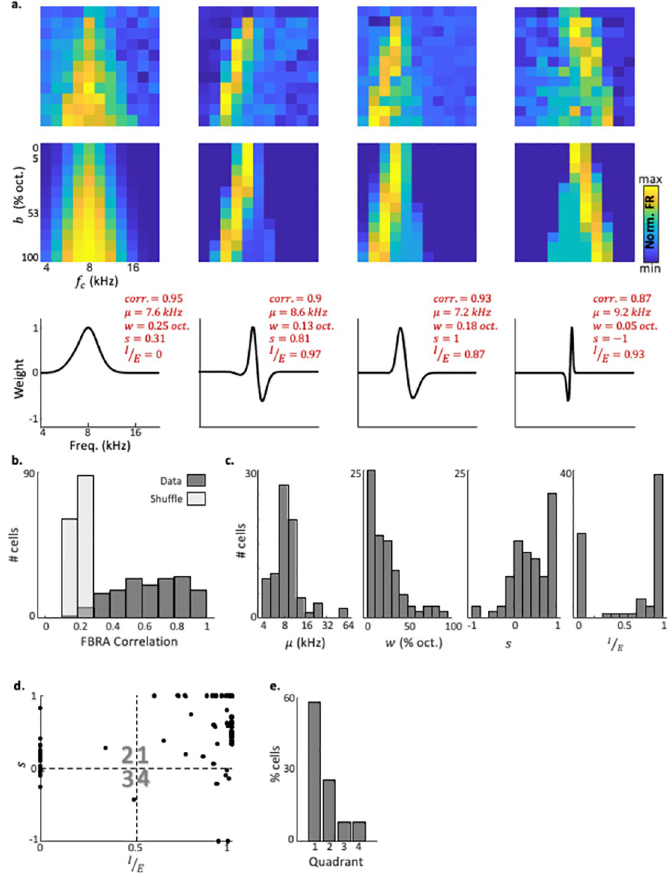
Fig 3. The MRW model provides a mechanistic explanation to neuronal FBRAs. a. Top: FBRAs of 4 neurons from 3 mice. Middle: model FBRAs fitted to the same neurons. Bottom: fitted MRWs of the same neurons. b. Distribution of FBRA correlation values (Pearson correlation) for all neurons in our dataset (n = 149 neurons, N = 5 mice) for real and shuffled data. The mean FBRA correlation value was 0.64 ± 0.21 (s.e.m). The mean value of shuffled data is 0.21 ± 0.03. c. Distributions of m ; w ; s ; I = values of n = 74 neurons. Only neurons with fit correlation higher than the median E (which is also 0.64) are shown. d. The combination of skewness and I/E values of n = 74 neurons. We define four quadrants of the graph (Q1-4), such that neurons with high S and I/E are in Q1. The graph shows two main sub- population of neurons in ACx—in Q1 and in Q2. e. Distribution of the number of neurons in each of the quadrant’s shown in panel ‘d’, showing the predominance of neurons with high model fits to